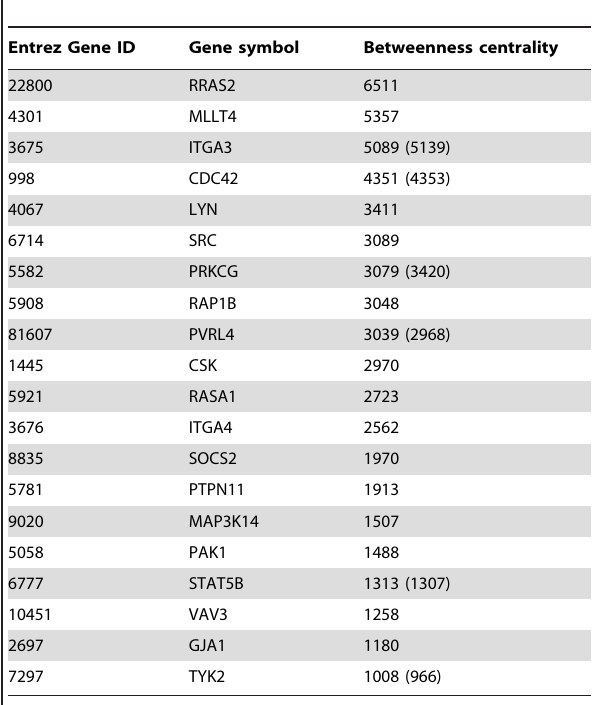
Table 1. List of seed genes for detecting significant switch of